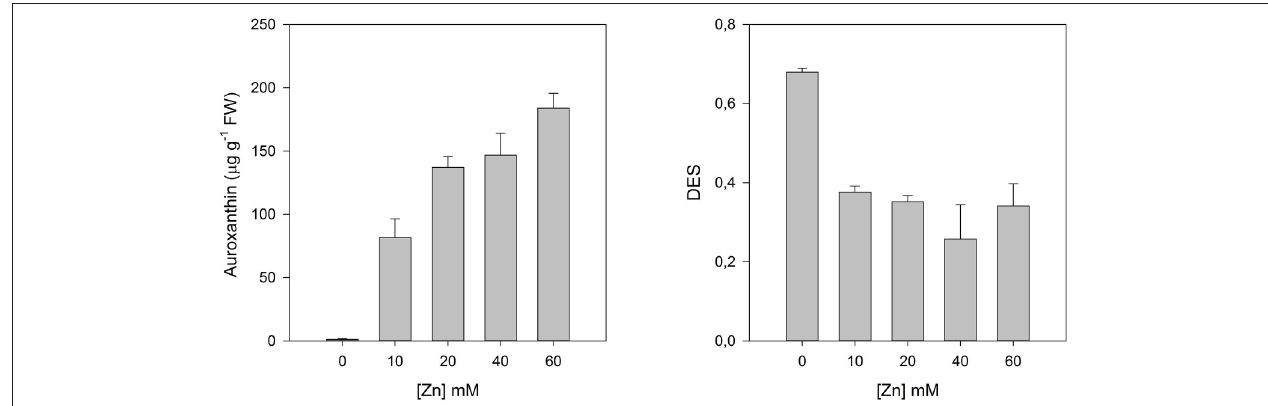
FIGURE 9 | Auroxanthin contents and de-epoxidation state (DES) index in Juncus accutus plants exposed to increasing concentrations of copper (Cu). Data is presented as average ± standard deviation. The concept of this figure is based on Santos et al. (2014).